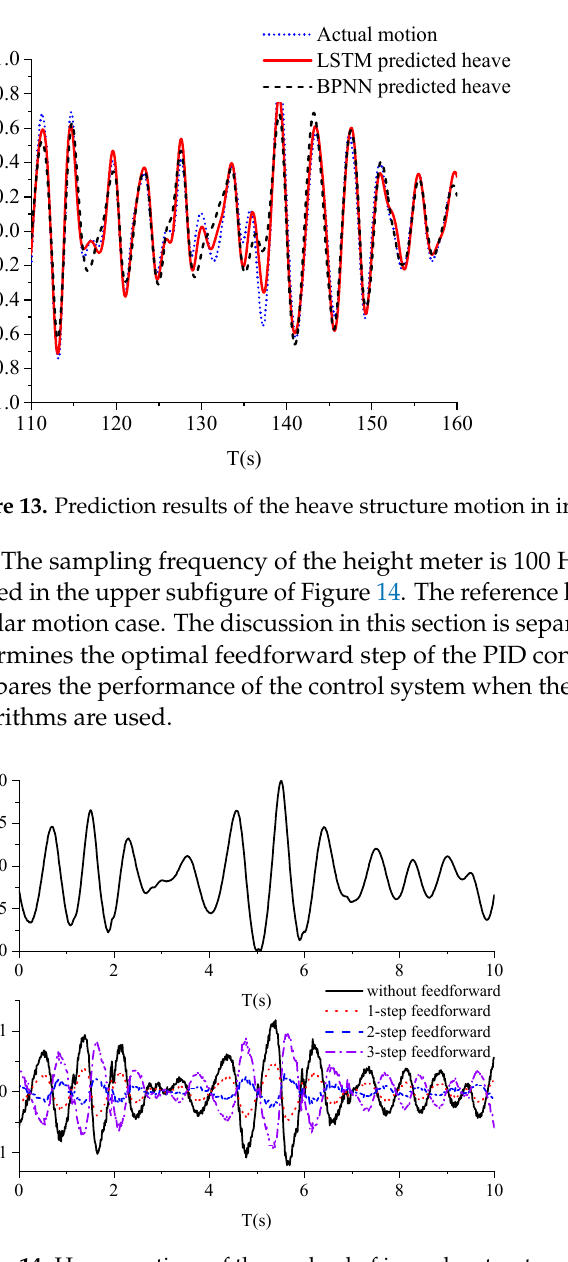
Table 6. Comparison of the deviation of di ff erent prediction algorithms.